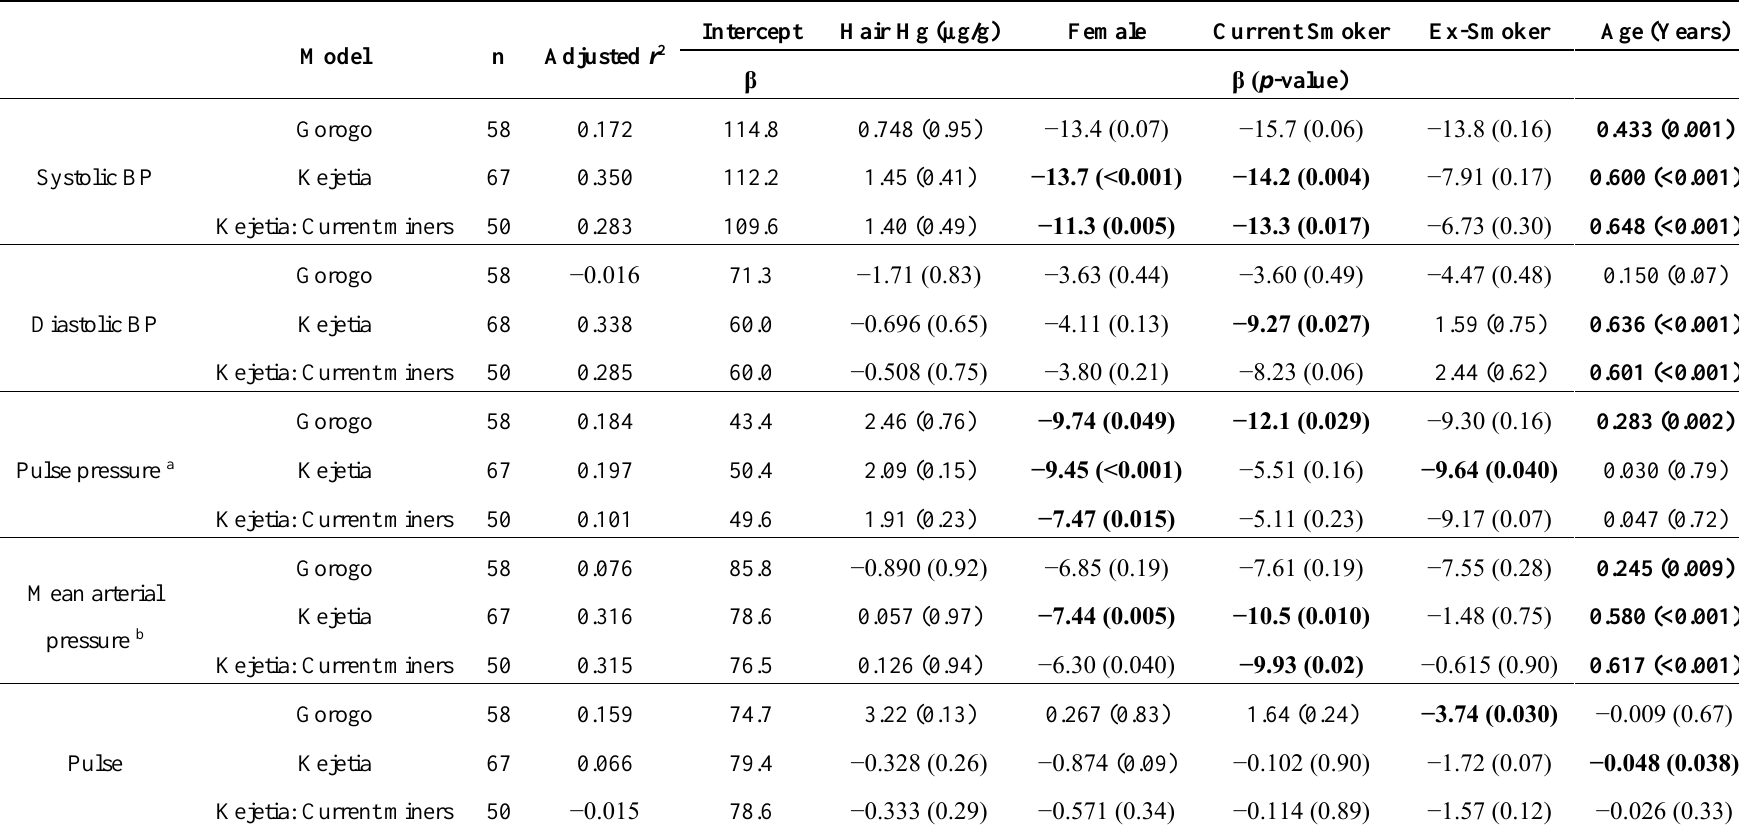
Table 4. Results of linear regression models for BP measures and hair Hg concentrations. Each line represents a separate model. Analyses excluded participants with emergency high BP statuses (n = 4). Statistically significant results are in bold